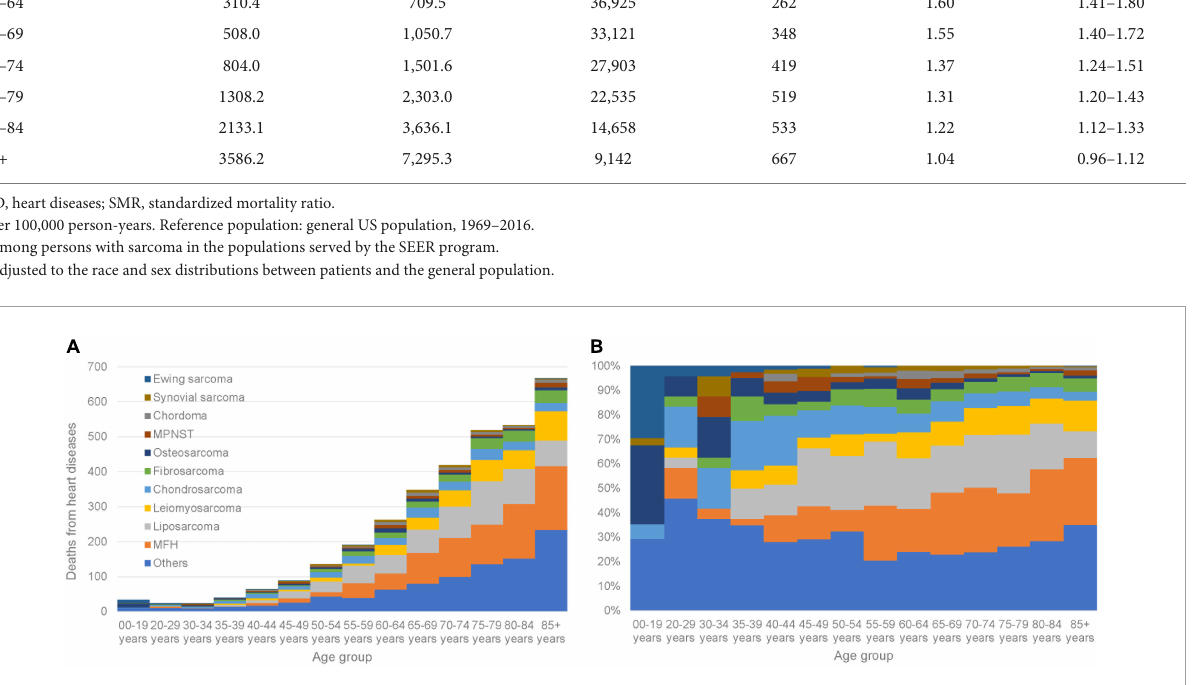
as a function of age group is shown ( Figure 2 ). In patients diagnosed at < 19 years old, HD plurality occurred in those with Ewing sarcoma (29.4%) and osteosarcoma (32.4%). In contrast, in patients diagnosed at > 35 years old, HD plurality occurred in those diagnosed with liposarcoma (19.0%) and MFH